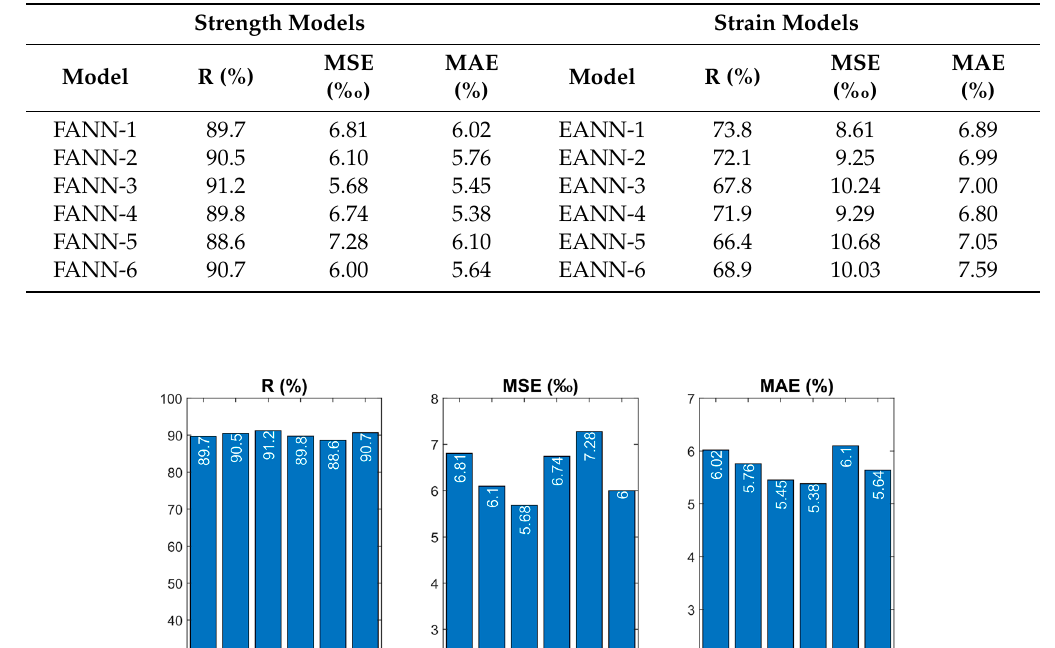
Table 8. Prediction performance of the di ff erent ANN models for strength and strain (for the normalized values of f cc / f (cid:48) co and ε cc / ε co , respectively.